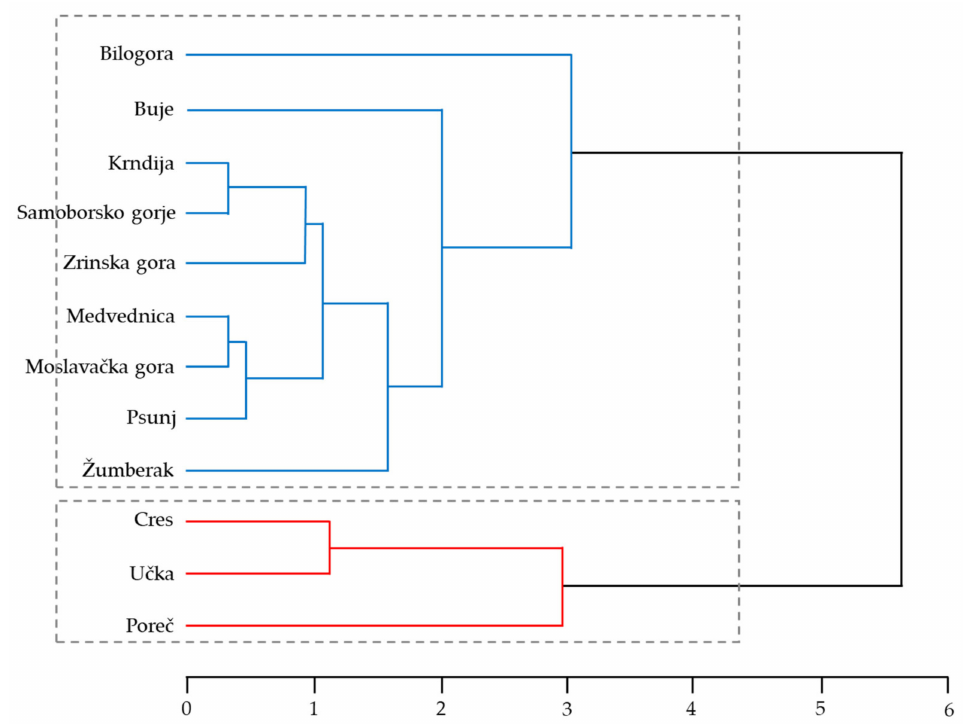
Figure 2. Tree diagram of the 12 sweet chestnut populations studied. The unweighted pair-group method with arithmetic mean (UPGMA) was used to join the clusters, and the Euclidean distance was used to define the distance between the studied populations. Table 3. Pearson’s correlation coefficient among the seed mass, germination and seedling charac- teristics of the 12 sweet chestnut populations studied. Statistically significant values are marked in bold. Levels of significance: *** significant at p < 0.001, ** significant at 0.001 < p < 0.01, *